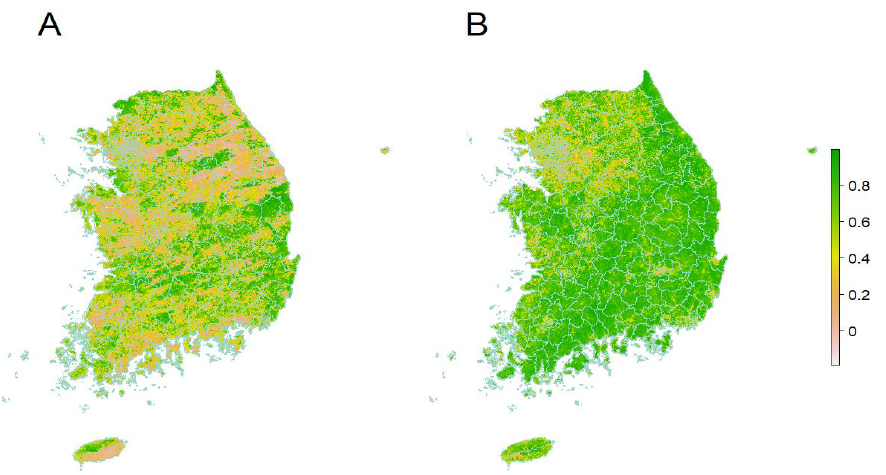
Figure 1. Residential greenness on July 2006 ( A ) and 2014 ( B